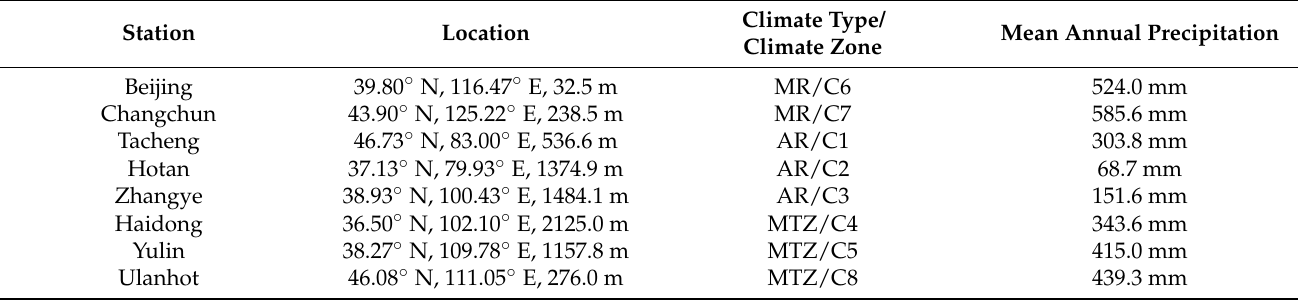
Table 1. Information of Representative Stations in Different Climate